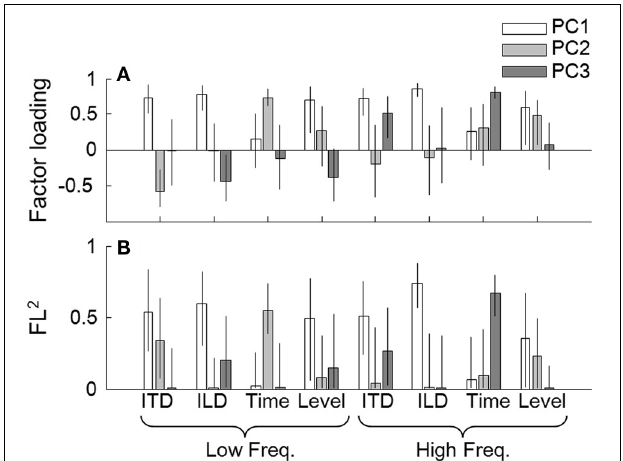
FIGURE 5 | (A) Factor loadings on the individual tasks, derived by the principal component analysis. The loads for the three components (i.e., PC1, PC2, and PC3) are represented by the three bars as indicated in the key. The error bars indicate 95% confidence intervals of the loads estimated by the bootstrap method. (B) Squared factor loadings (indicating the proportion to the total variance for the task accounted for by that component). Other conventions are the same as in (A)